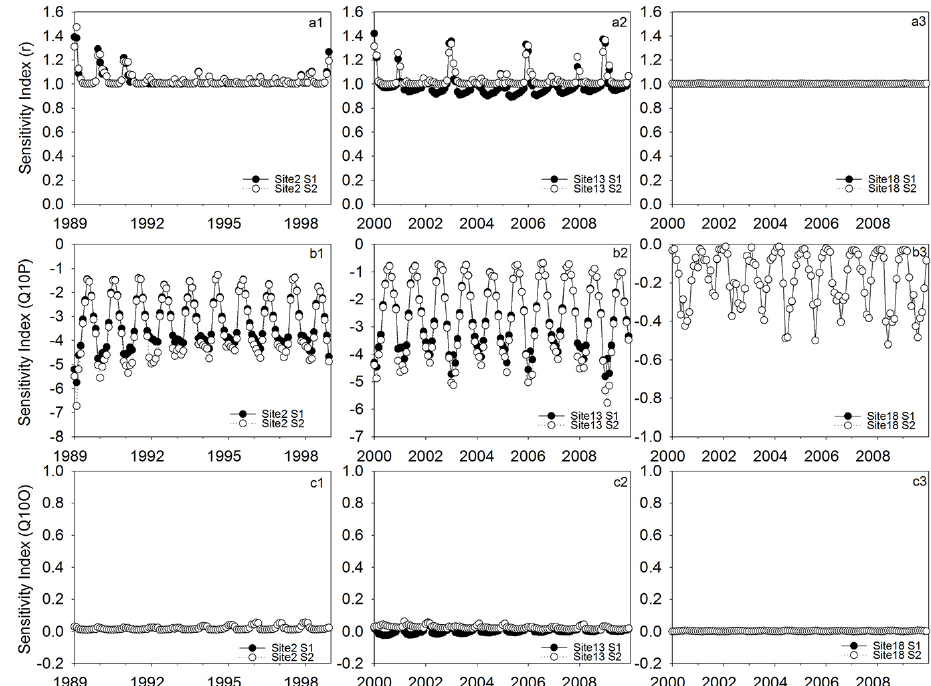
Figure 2. Sensitivity analysis of the three parameters ( r , Q 10 P, Q 10 O) in the CH 4 module at three selected sites for different biome regions: boreal (site 2), temperate (site 12), and tropical (site 18). S1: scenario with single 1x ; S2: scenario with double 1x